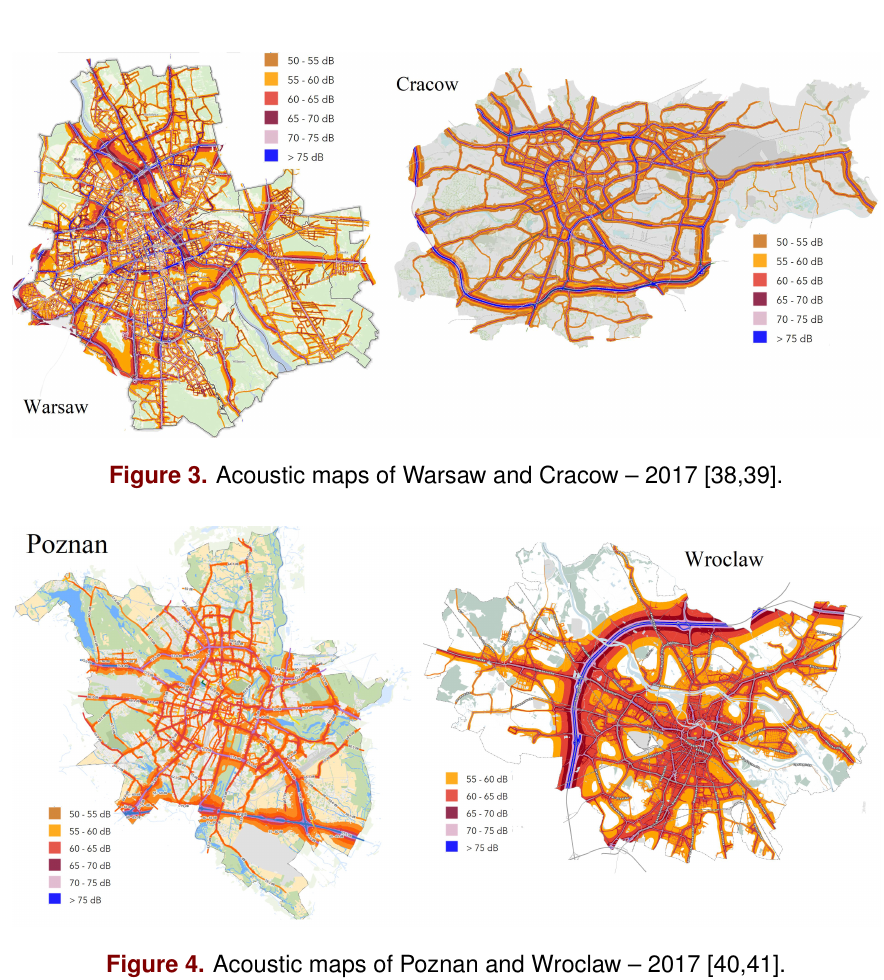
Figure 4. Acoustic maps of Poznan and Wroclaw – 2017